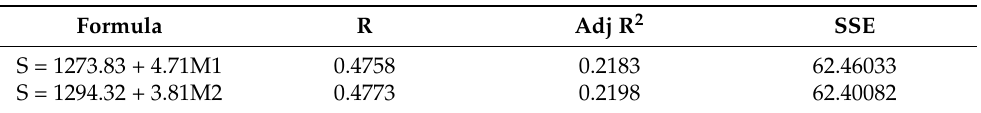
Figure 3. Relationship between the length of the metatarsal bones and stature in males and females, the relationship between the length of the first metatarsal and stature is shown in ( A ) and between the length of the second metatarsal and stature is shown in ( B ). There is a positive correlation between the length of both bones and stature ( p < 0.0001). Table 3. Regression formulae for females with its correlation coefficient (R), adjusted determination coefficient (Adj R 2 ), and standard error of estimate (SEE).